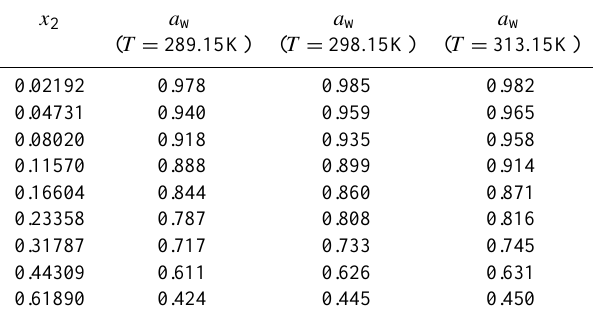
Table 4. Bulk water activity (a w ) measurements ∗ of water (1) + 1,4-butanediol (2) solutions at three different temperatures. Solution compositions are given in mole fraction ( x 2 ) of the organic compo- nent (2).